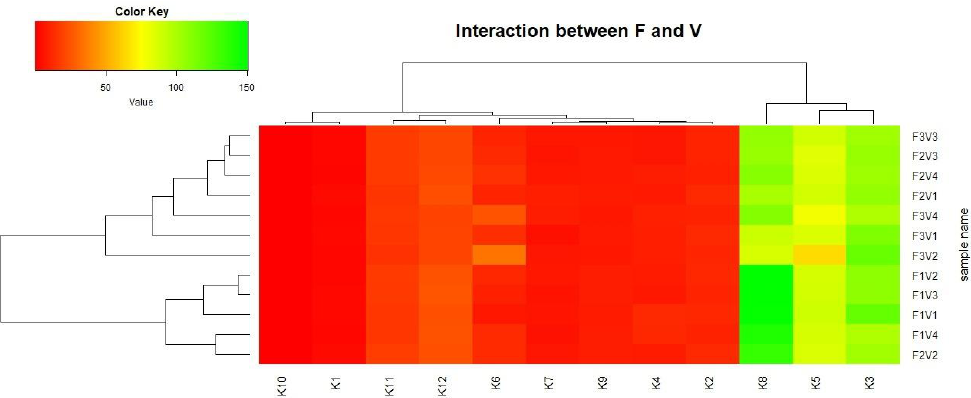
Figure 3. Grouping interaction FxV based on agronomic parameters. Note: K1 = Straw production (t ha − 1 ); K2 = Total biomass (grain + straw) t ha − 1 ; K3 = Plant height on 112 DAP (cm); K4 = Tiller number per plant on 112 DAP (pcs); K5 = Filled Grain per panicle (%); K6 = Unfilled grain per